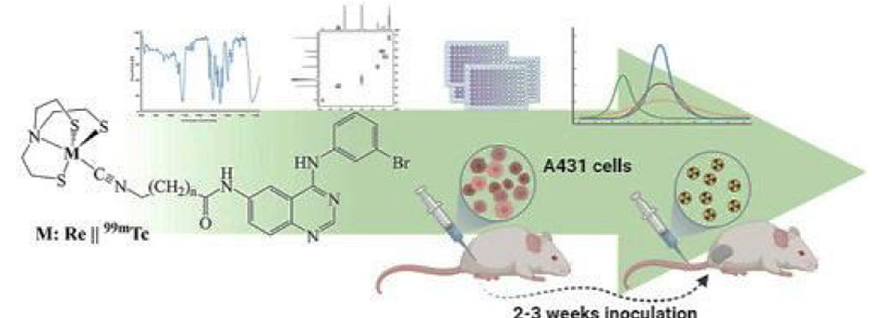
Fig. 5 Schematic overview of preclinical experiments to evaluate 99m Tc labelled EGFR imaging agents. (from Kiritsis et al.